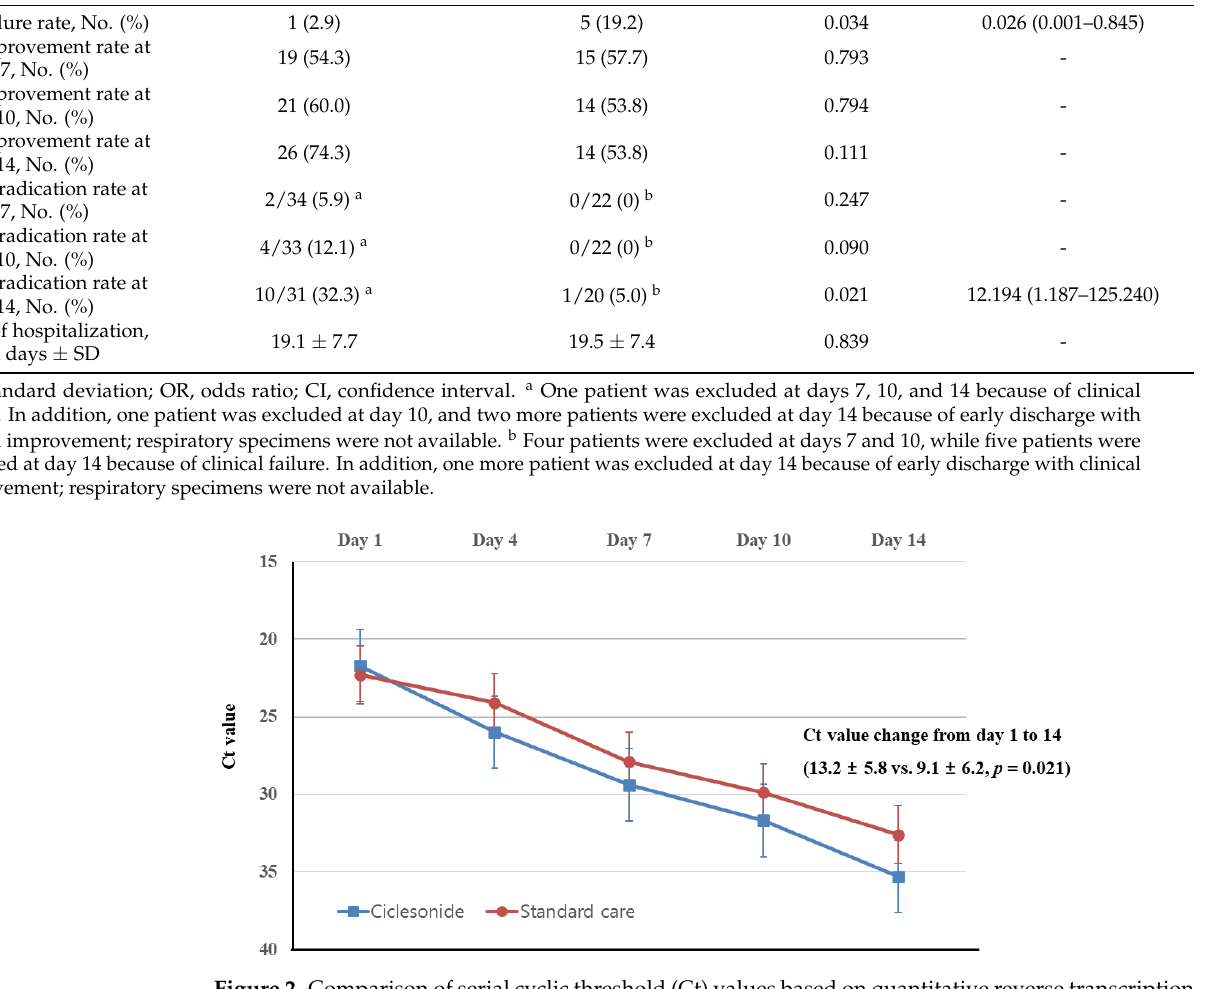
Figure 2. Comparison of serial cyclic threshold (Ct) values based on quantitative reverse transcription polymerase chain reaction targeting RdRp gene between ciclesonide and standard care groups. Four patients of ciclesonide group and six patients of standard care group were excluded in the analysis because of clinical failure or early discharge with clinical improvement, respectively.